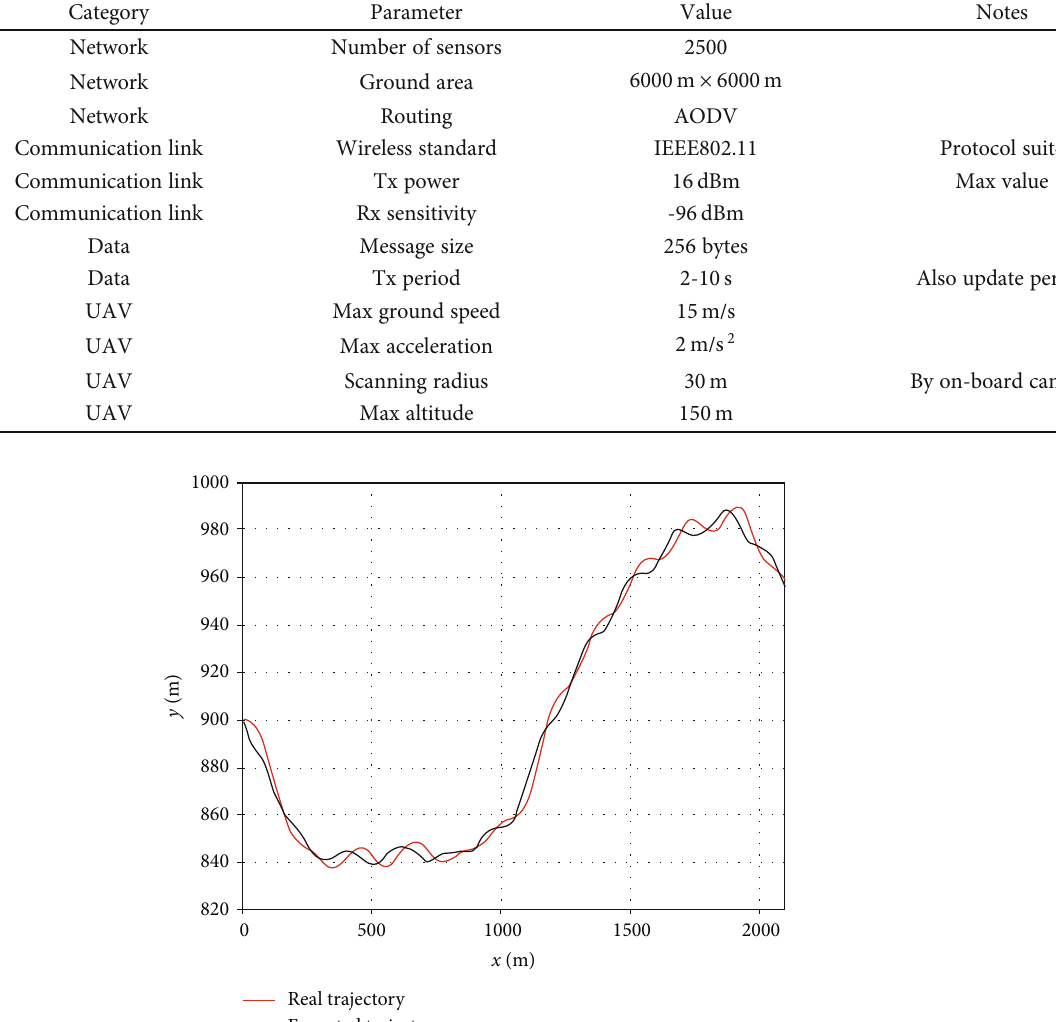
Table 3: System parameter setup for simulation scenarios.